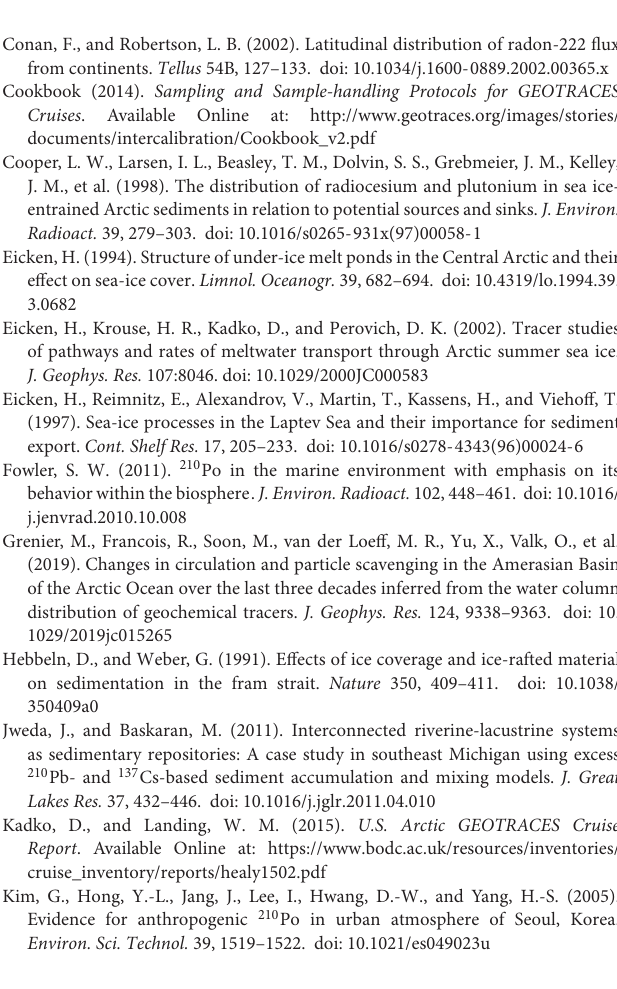
Supplementary Figure 1 | Vertical profiles of salinity in 5 ice